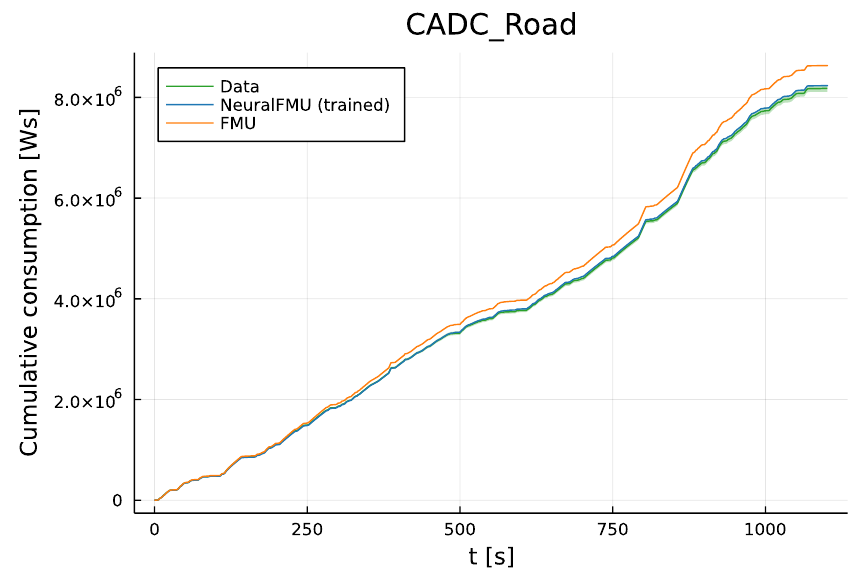
Figure 10. Cumulative consumption prediction on the CADC Road , which is part of the training data. The NeuralFMU (blue) lies almost on the training data mean (green) and inside the data uncertainty region (green, translucent). On the other hand, the simulation results of the original FPM/FMU (orange) slowly drifts out of the data uncertainty region, resulting in a relatively large error at the simulation stop time compared to the